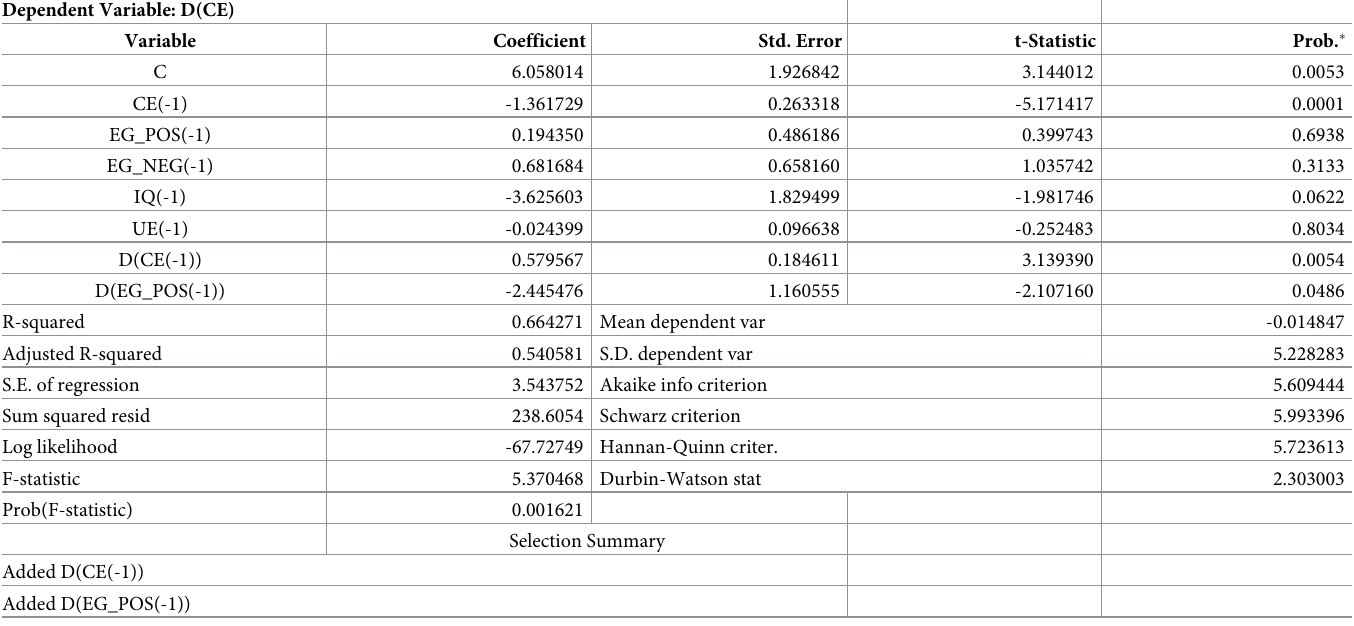
Table 5. Stepwise regression.